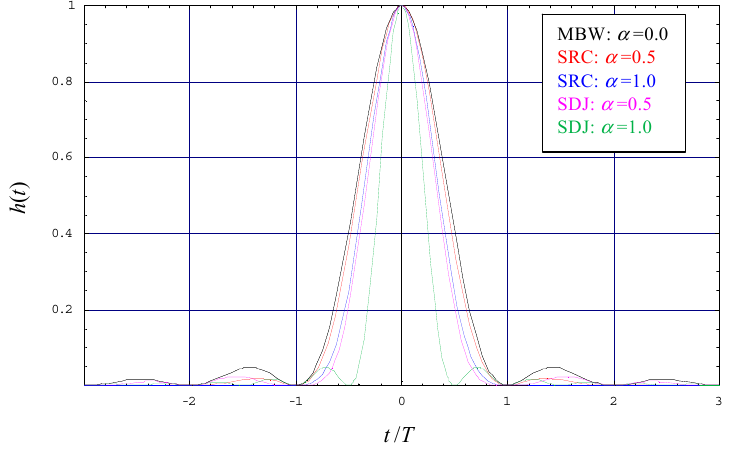
Figure 1. Evolution of non-negative pulse shapes used for bandlimited OWC.